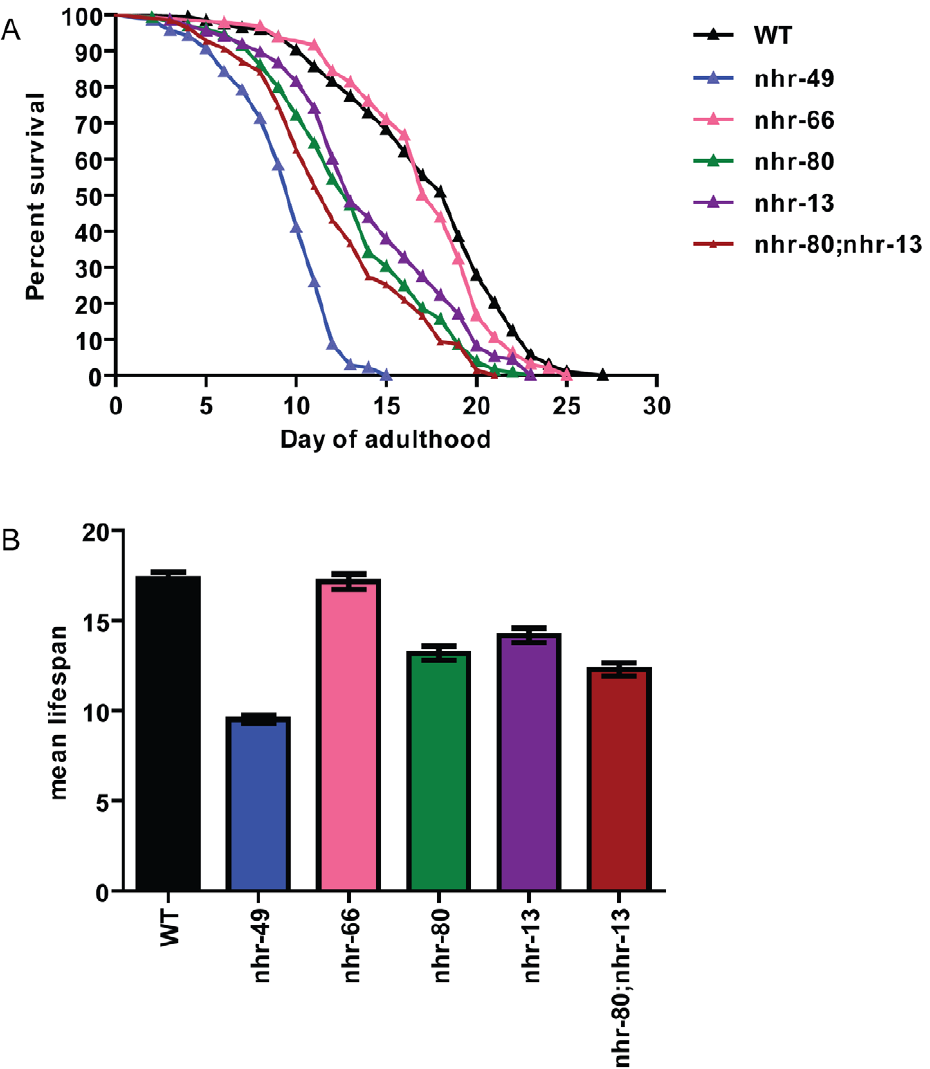
Figure 4. nhr-80;nhr-13 double mutants have a reduced lifespan comparable to that of nhr-49 animals. (A) The percentage of animals remaining alive is plotted against animal age. Adult lifespan survival curves of WT (black), nhr-49(nr2041) (blue), nhr-66(ok940) (pink), nhr-80(tm1011) (green), nhr-13(gk796) (purple) and double mutant nhr-80; nhr-13 (brown) animals. (B) The bar graph represents the combined mean ( + / 2 SEM) adult lifespan (days) from at least four independent